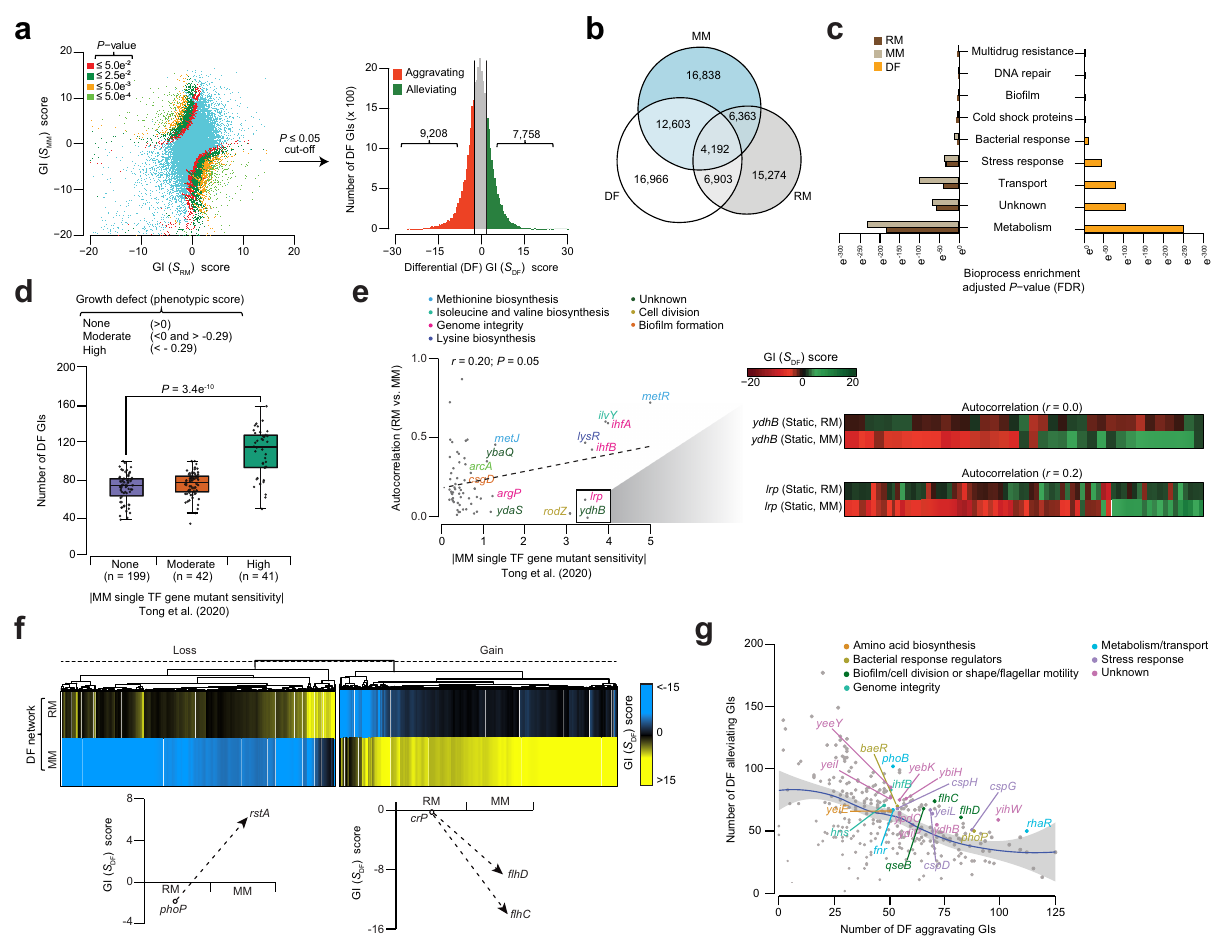
Fig. 5 Differential networks reveal new TF gene functions. a Scatterplot (left) of GI scores of RM vs. MM static networks at various P -value-based cut- offs ( ≤ 5.0 e − 2 , 2.5 e − 2 , 5.0 e − 3 , 5.0 e − 4 ) after Z-score transformation. Histogram (right) of differential GI scores of the Z-score transformed P -value fi ltered at a signi fi cance level of 0.05 with tails representing signi fi cant epistatic interactions. b Venn showing the overlap of signi fi cant GIs in static and differential networks. c Enriched TF bioprocesses ( P -value signi fi cance by hypergeometric test, and adjusted using the Benjamini-Hochberg FDR correction) in static and differential networks. d , e Distribution of differential GIs ( d ; from left to right, n = 199, 42, and 41) or correlation of GI pro fi les ( e ) for each query TF gene between RM and MM networks (i.e., Autocorrelation) is plotted against single TF gene mutant growth fi tness sensitivity in MM from a recent phenotypic genetic screen 46 . Autocorrelation pro fi les for two representative query TF genes ( ydhB , lrp ) are shown ( e ); P = 3.4 e − 10 by two-sided Wilcoxon signed-rank test ( d ) and P = 0.05 by t -distribution for Pearson ’ s correlation coef fi cient ( e ). Box plot ( d ) from left to right is shown with maximum (100, 102, and 159), minimum (39, 44, and 51), quartile 1 (Q1; 68, 72 and 93), Q2 (79, 80, and 118) and Q3 (82, 83, and 123) values. f Hierarchical clustering of GI patterns showing gene pairs with gain or loss of GI in RM or MM. Illustrative examples of two TF gene pair pro fi les are shown. g Differential GI hub TF genes in the indicated processes is plotted against the number of aggravating vs. alleviating differential GIs. Source data are provided as a Source Data fi